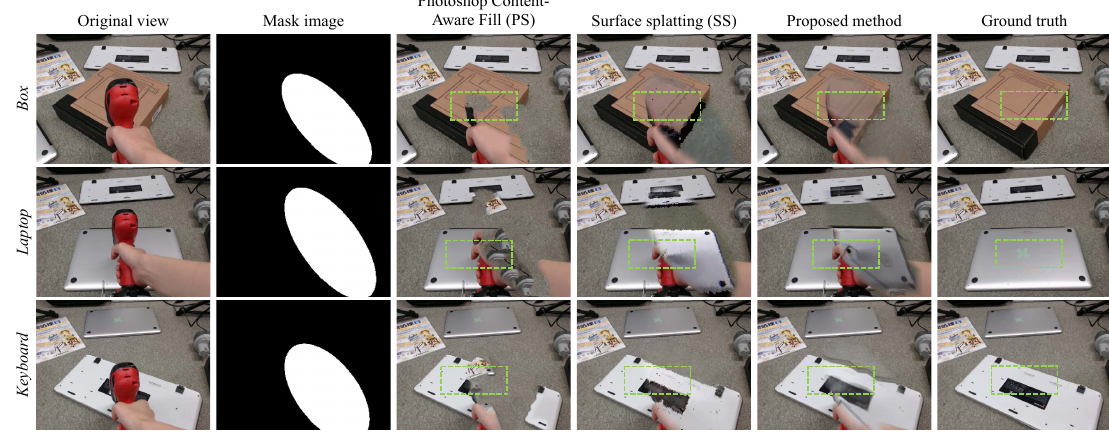
Figure 5. DR result images of the similarity evaluations.